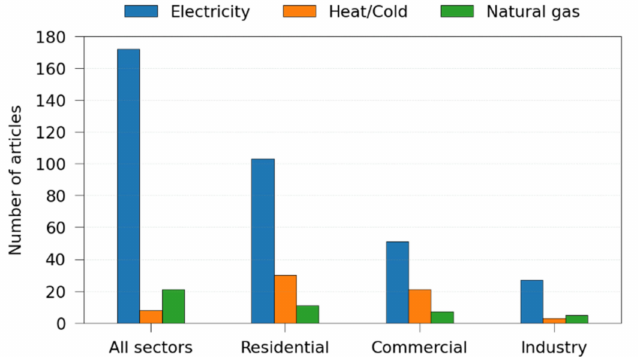
Figure 2. Sectors and energy carriers. The number of published articles is shown by sector and energy carrier. In most articles, the energy consumption of all sectors is modeled, e.g., of an entire region. Electricity consumption is modeled the most. In the residential and commercial sectors, a significant number of articles focus on heating and cooling demand in buildings.